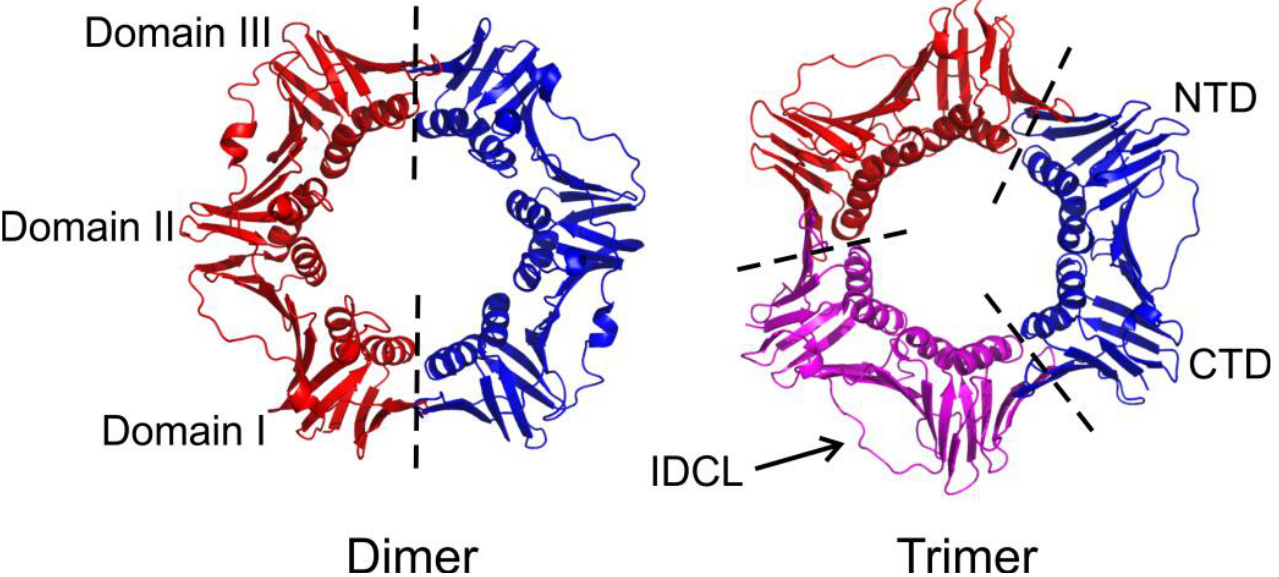
Figure 1. Comparison of a dimeric and a trimeric sliding clamp. The panel shows a comparison of a dimeric and a trimeric clamp. The dimeric clamp has three domains viz. domain I, domain II, and domain III, whereas a trimeric clamp has two domains viz. NTD (N-terminal domain) and CTD (C-terminal domain) per subunit. The broken line marks the subunit-subunit interface. Within a subunit, the two domains are connected through an amino acid region called the inter-domain connecting loop (IDCL). The image was generated using the Escherichia coli β -clamp (PDB ID: 1MMI) and human PCNA (PDB ID: 1VYM).